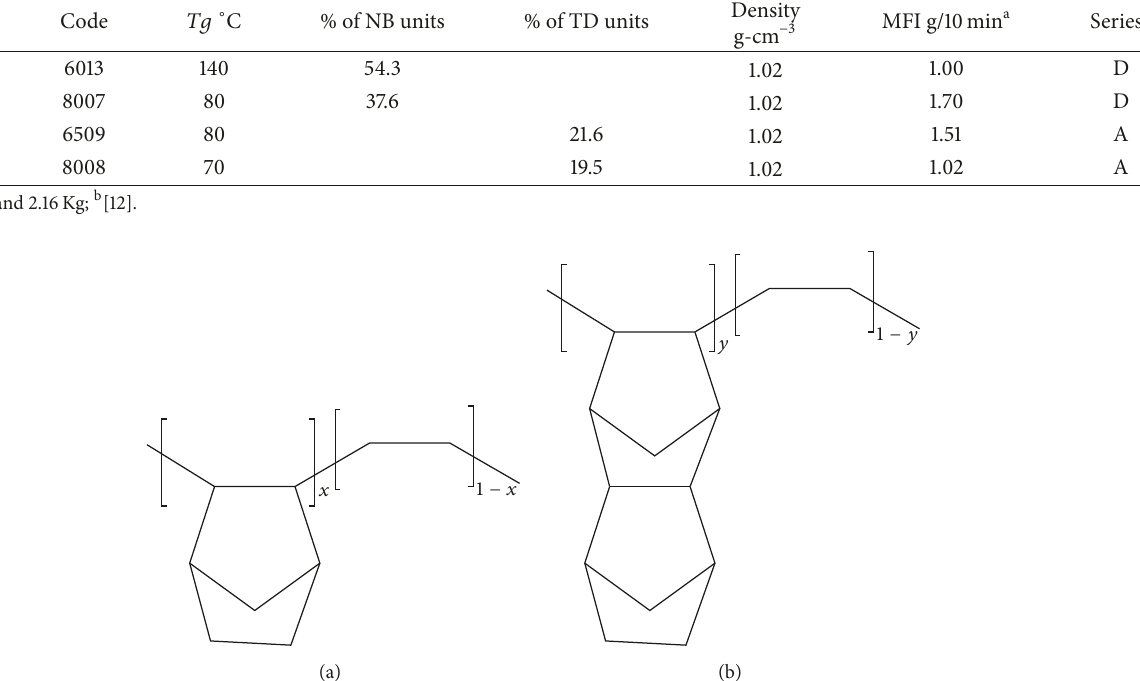
Figure 1: Structure of COC copolymers. (a) Ethylene-norbornene (E-NB) copolymer: Series D. (b) Ethylene-tetracyclododecene (E-TD) copolymer: Series